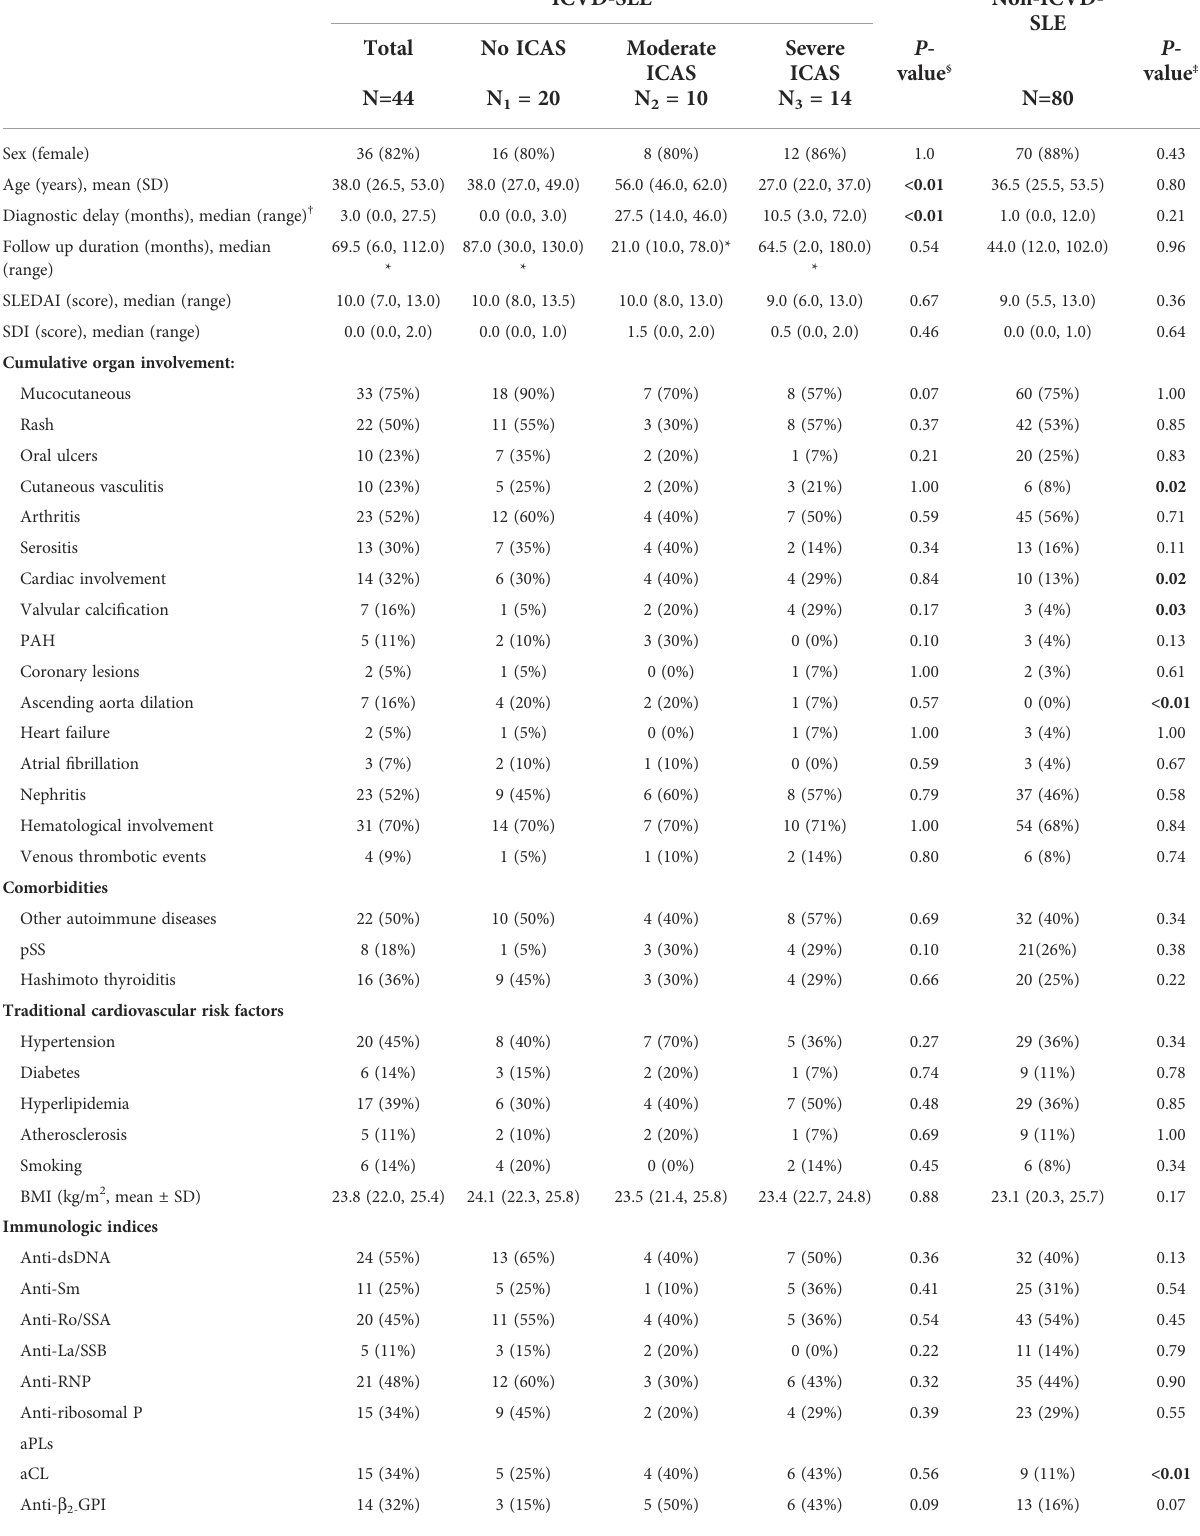
TABLE 1 Comparison of demographic, clinical, and serological characteristics between groups of lupus